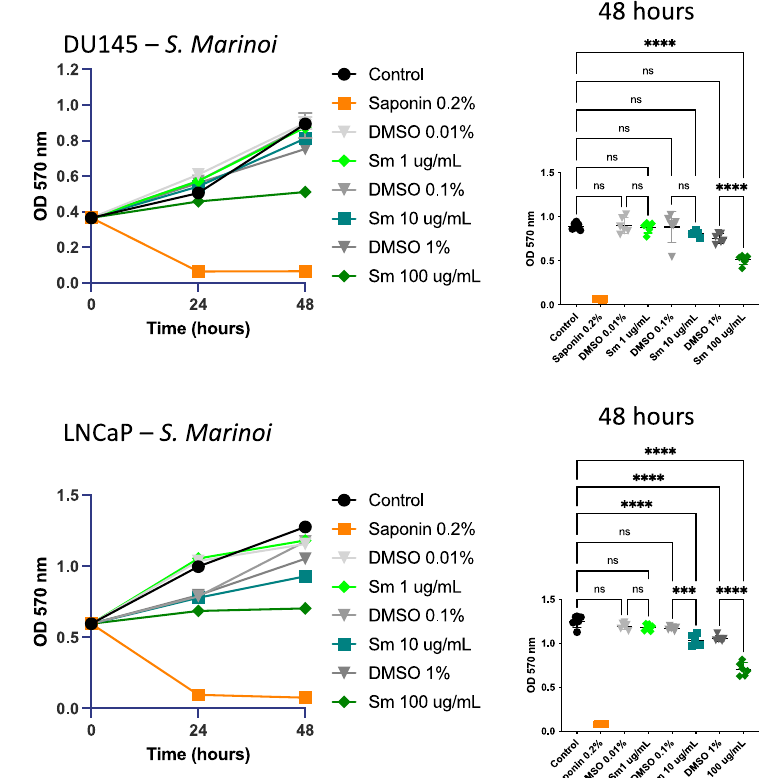
Figure 1. Effects of S. marinoi extract on prostate cancer (PCa) cell line proliferation. The proliferation rate was measured by ( A ) crystal violet assay (OD 595 nm) at 72 h and ( B ) MTT (OD 570) at 48 h. DU145 cells were treated with S. marinoi (Sm) at 1–10–100 µg/mL, LNCaP cells were treated with Sm